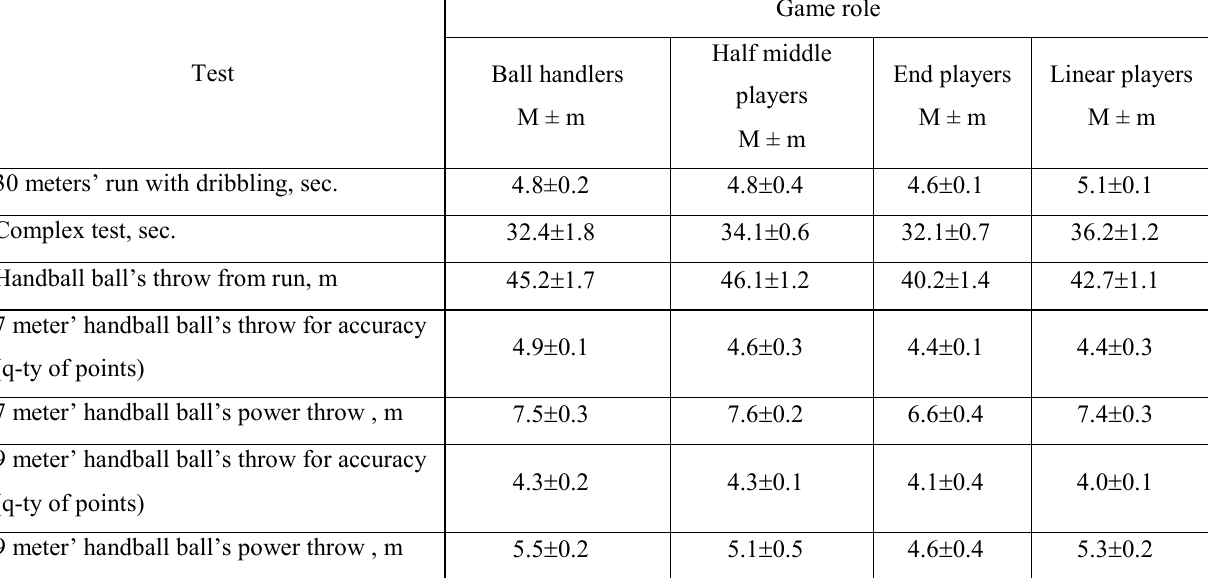
Indicators of special speed-power fitness of female handball players after implementation of the worked out methodic